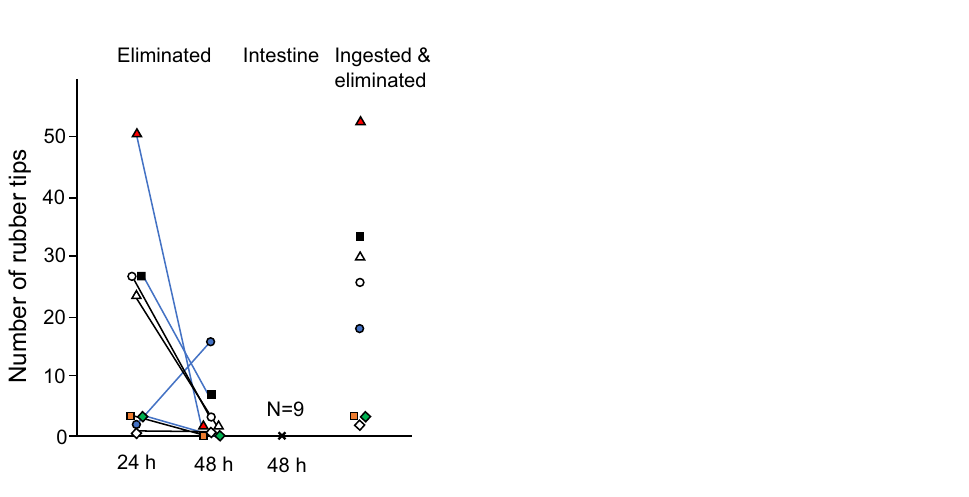
Figure 8. Retention and elimination of ingested rubber tips in the intestine of goldfish. Eight out of nine fish ingested and eliminated rubber tips. Each symbol indicates the number of rubber tips collected in the